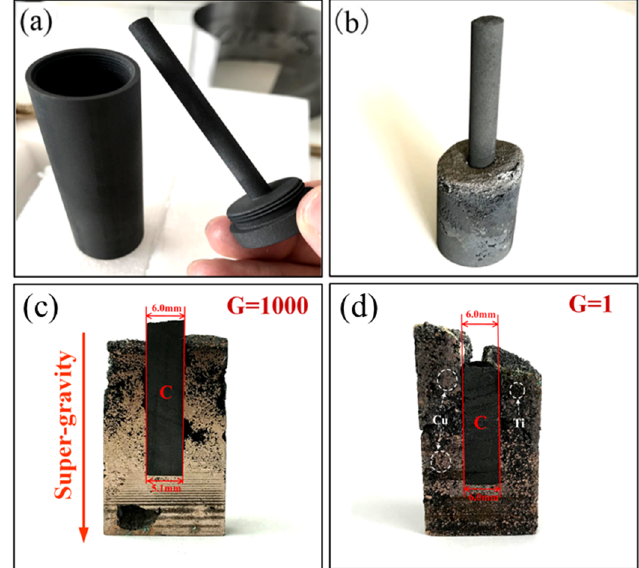
Figure 5. Comparison of the size change in solid C rods dissolved by Cu-Ti melt under normal gravity and super-gravity conditions ( a ) image of the designed graphite crucible; ( b ) the image of the sample after heating treatment; ( c ) the cross-section morphology of the sample after super-gravity treatment with G = 1000; ( d ) the cross-section morphology of the sample after heating in normal gravity.